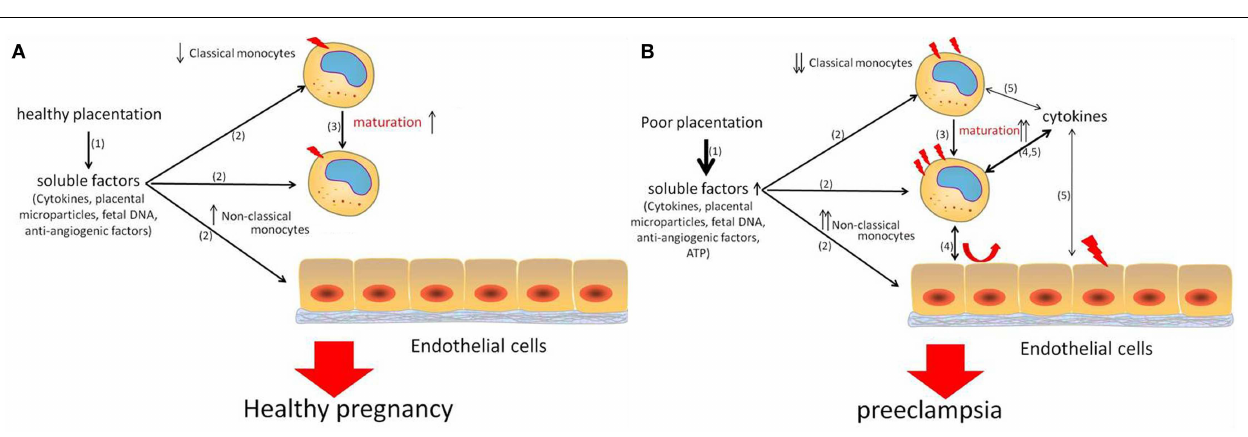
FIGURE 2 | Schematic overview of the role of monocytes during healthy pregnancy (A) and pre-eclampsia (B) . During healthy pregnancy, placental factors (1) activate monocytes (2) and may affect endothelial cells (2) and induce increased maturation of classical monocytes toward non-classical monocytes (3). During pre-eclampsia, more and other soluble factors are produced from the stressed placenta (1), resulting in further activation of monocytes and endothelial cells (2) and further maturation of classical